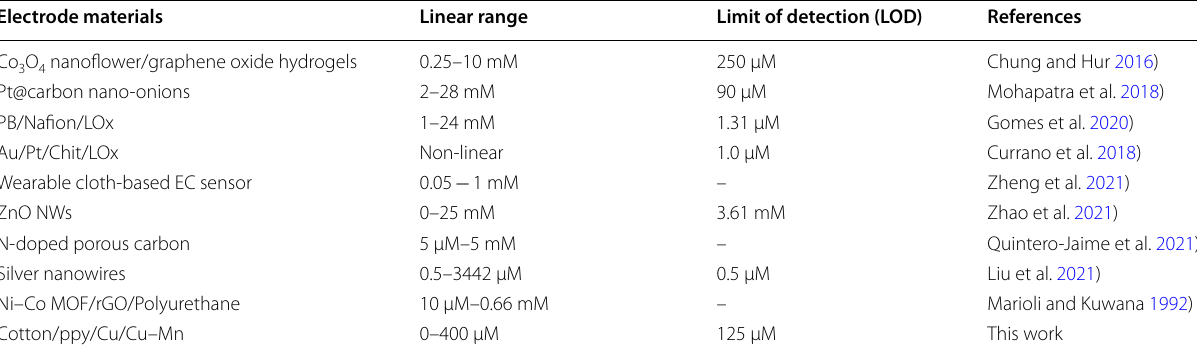
Table 1 Comparison of glucose sensor made from different electrode